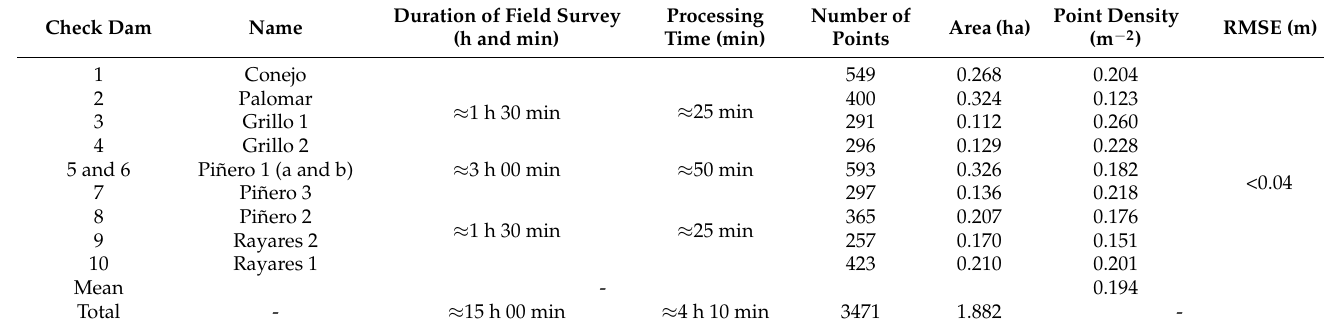
Table 4. Results of the topographic surveys using a total station and GNSS/RTK in ten check dams of Sierra de Los Donceles forest (Castilla-La Mancha, Spain).